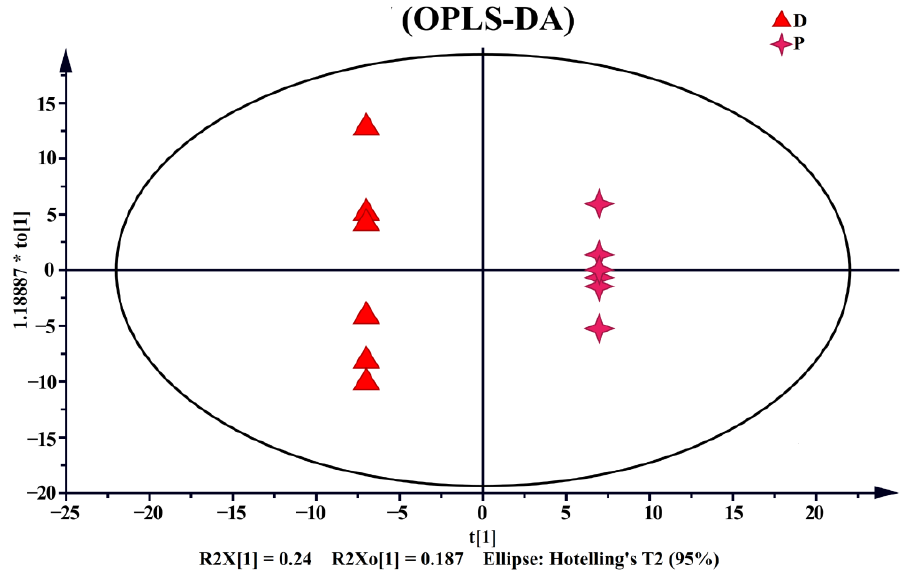
Figure 5. OPLS-DA score map of bayberry rhizosphere soil of the fungicide prochloraz treatment. D and P represent decline-diseased trees alone or in trees affected by decline disease in combination with the fungicide prochloraz, respectively. Effect of the fungicide prochloraz on differential metabolites analysis.